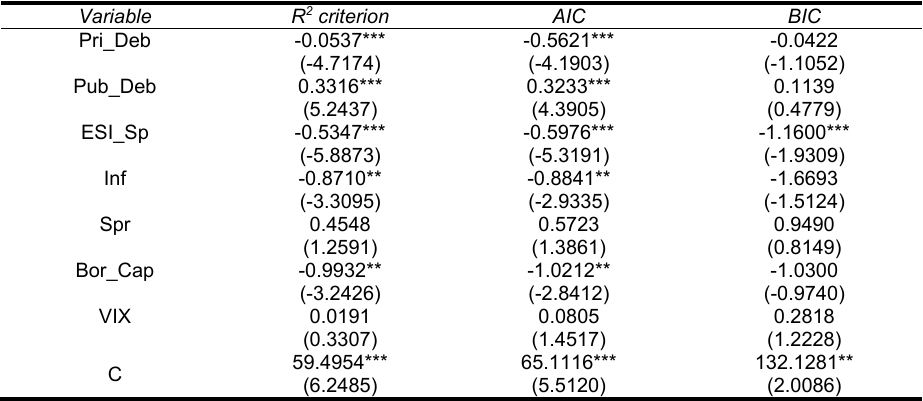
Table 6. ARDL coefficients in the long term model